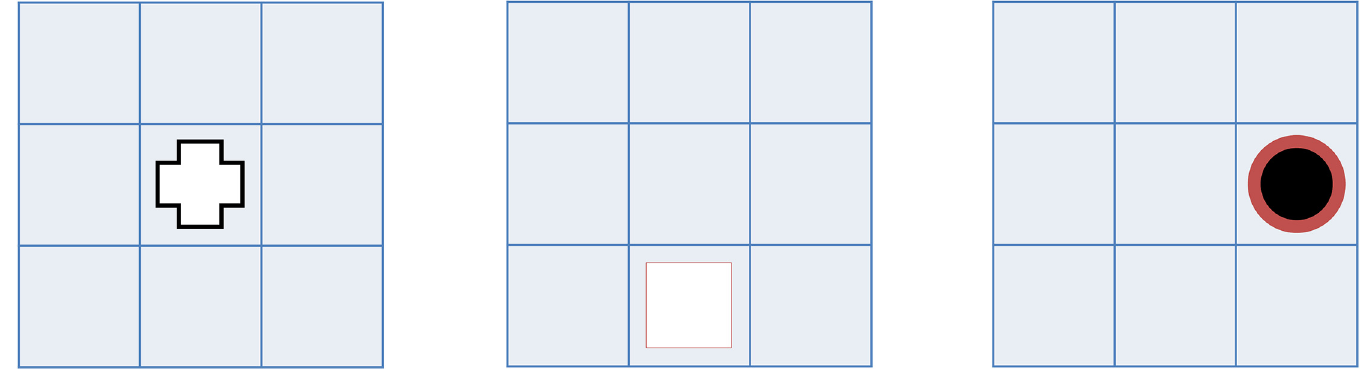
Fig 2. Examples of the VisMem stimuli. From left to right: VisMem – updating cross, VisMem – single task or switch trial white square with thin borders (sort by shape), and VisMem – single task or switch trial black circle with thick borders (sort by color).